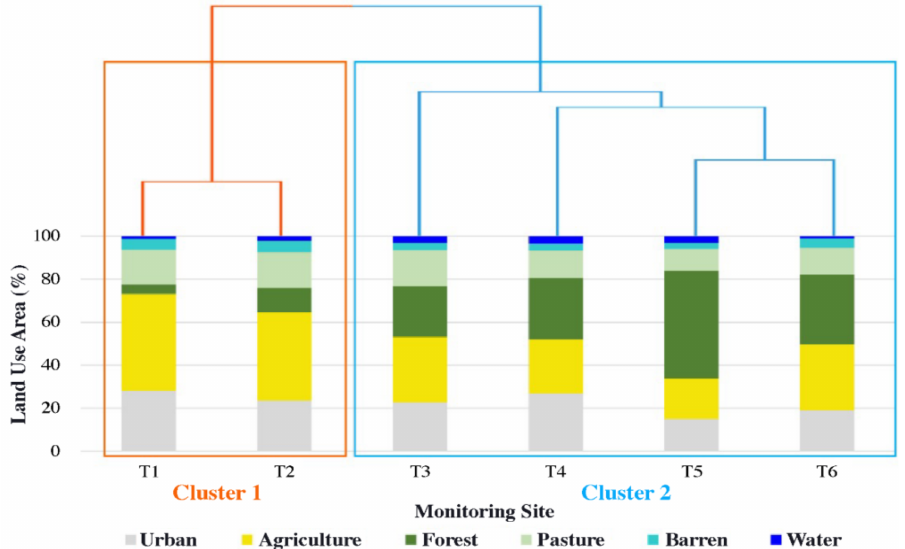
Figure 2. Cluster analysis results according to the characteristics of land use/cover in major tributary basins of the Miho upstream